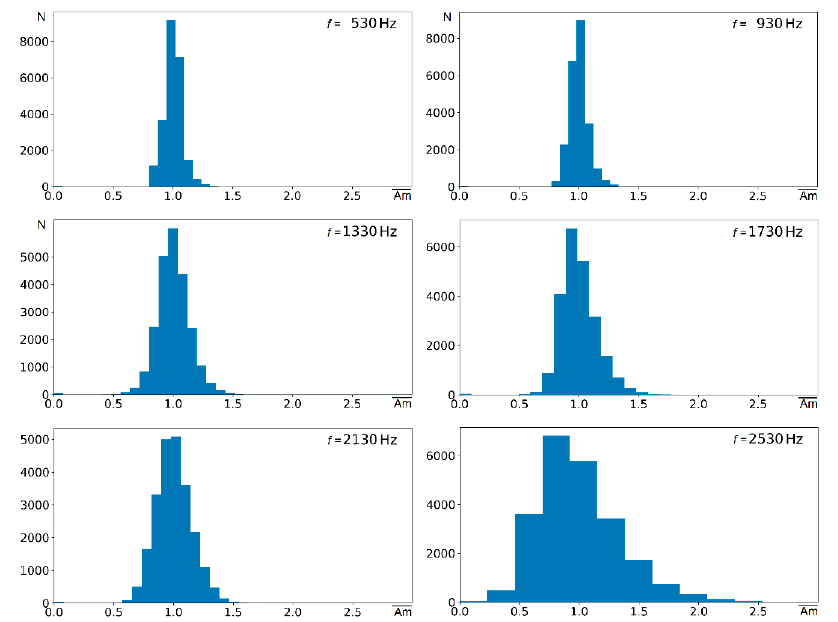
Figure 11. Histograms of corrected spectra are plotted for six frequencies (the frequency values are given in the figures).